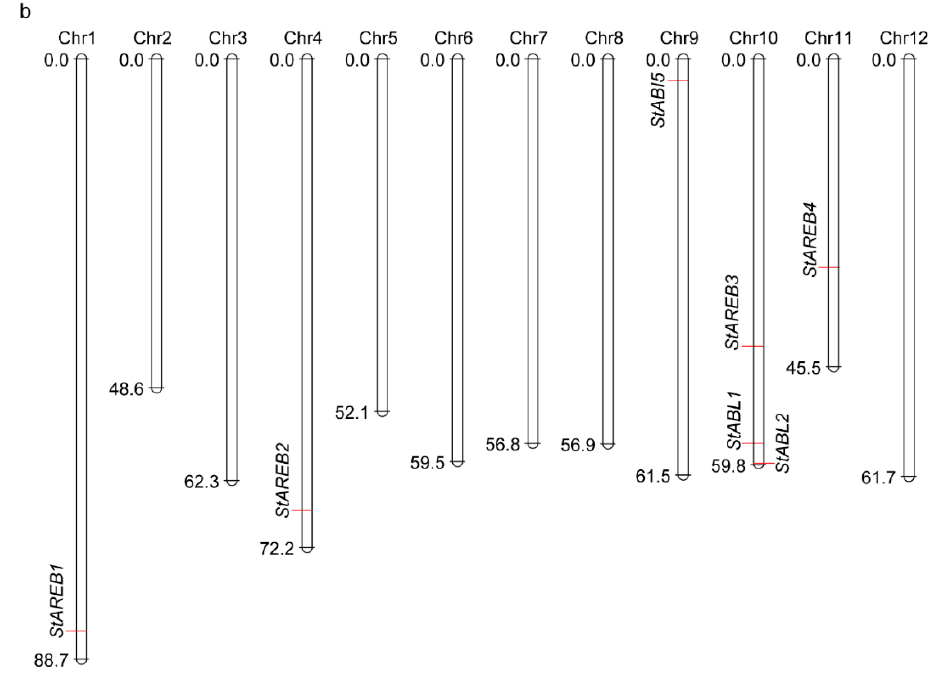
Figure 1. Sequence analysis and chromosomal localization of potato AREB/ABF/ABI5 members. ( a ) Neighbor-joining tree of potato and Arabidopsis AREB/ABF/ABI5 proteins and the gene structure of each potato AREB/ABF/ABI5 member. The sizes (bp) of exons are as indicated. ( b ) The seven identified AREB/ABF/ABI5 members were mapped on the four chromosomes.